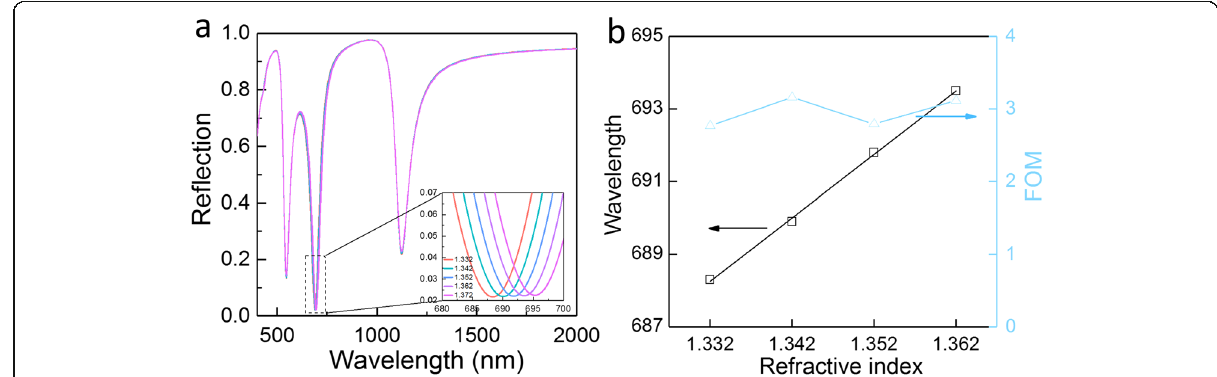
Fig. 6 a Normal incidence reflection spectra of the proposed nanohole array-based absorber with the refractive index of hole ( n ) changing from 1.332 to 1.372. The structural and material parameters are set as h 1 = 20 nm, h 2 = 250 nm, h 3 = 200 nm, ε 2 = 3.1, p = 200 nm, and w = 60 nm. b The position of reflection dip and calculated FOM as a function of the refractive index of holes ( n = 1.332 –